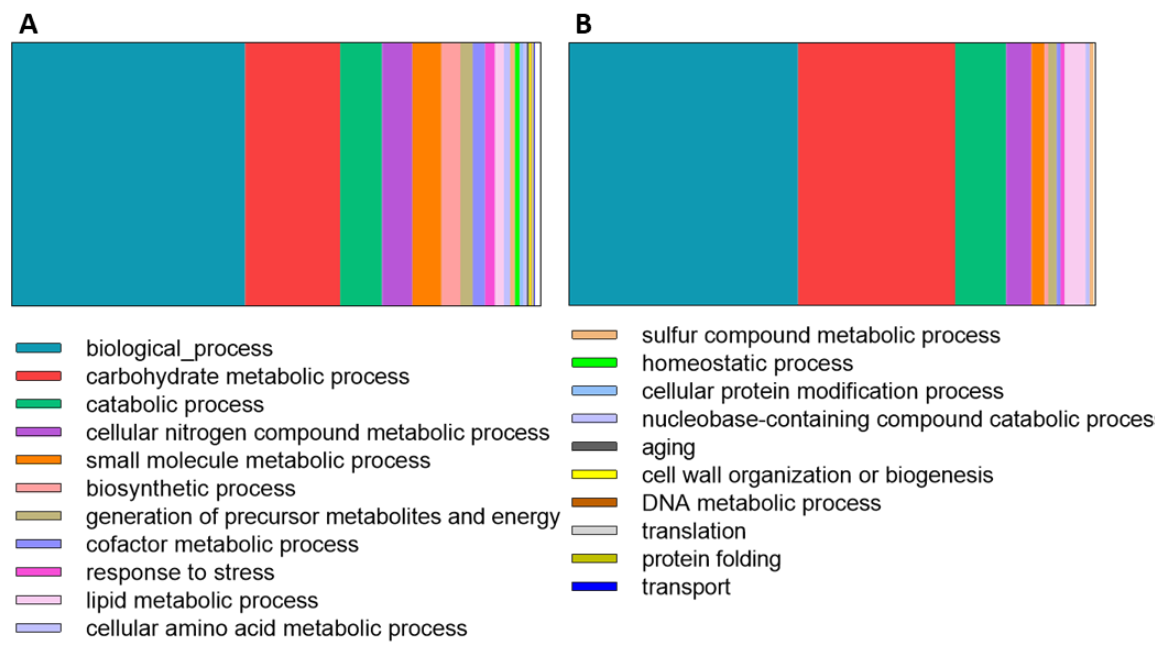
Figure 4. Gene Ontology (GO-Biological processes) of Neofusicoccum parvum proteins identified in ( A ) — control conditions and ( B ) — differentially expressed in the presence of the Eucalyptus stem.